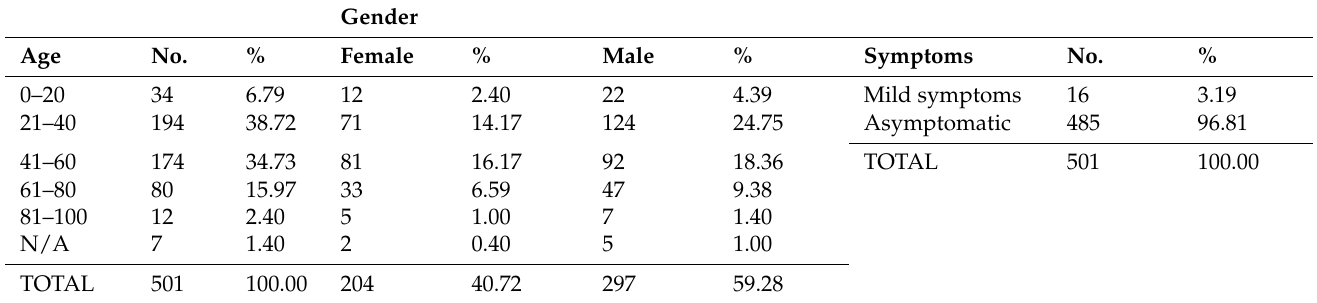
Table 2. Demographic data and symptoms’ manifestations of volunteers participating to